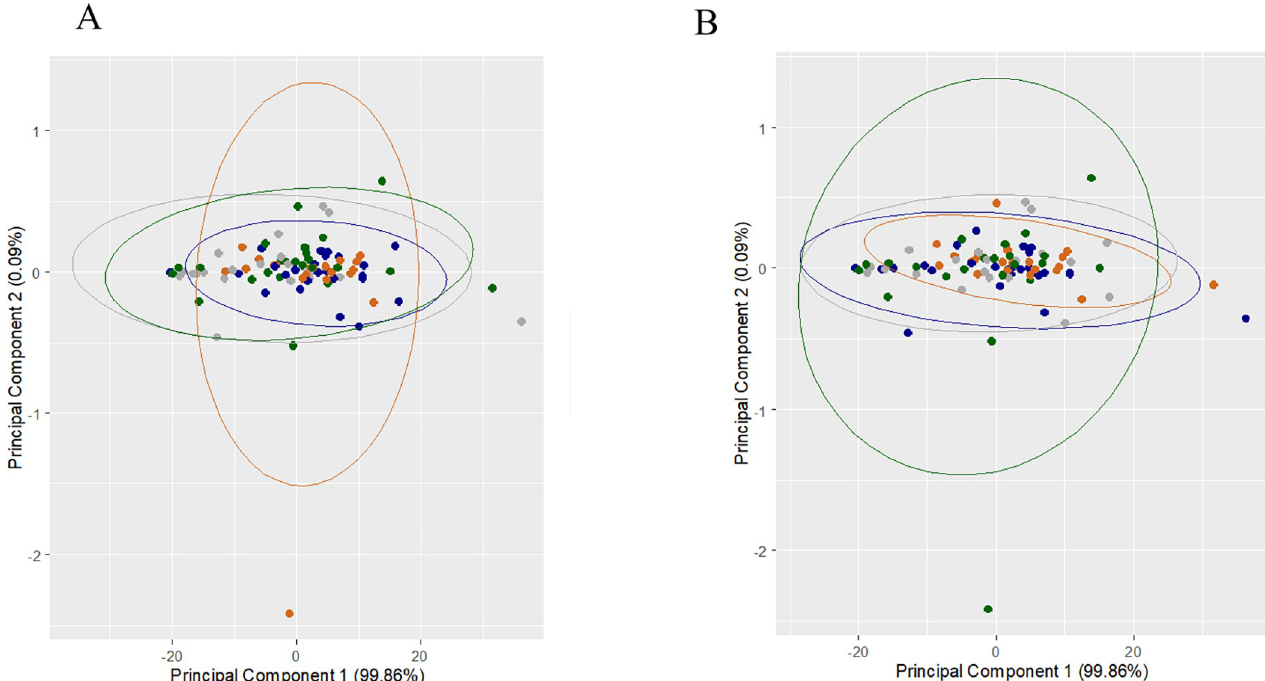
Fig 3. Principal component analysis bi-plot of the relative metabolite intensities of IVF and ICSI derived sibling embryos in relation to paternal factors. A) Bi-plot (PC1 vs PC2) of relative metabolite intensities of IVF and ICSI derived embryos in relation to sperm head defects did not demonstrate differential clustering. Blue dots (•) represents < 15% sperm head defects from IVF and orange dots (•) represents > 15% sperm head defects from IVF; whereas grey dots (•) represents < 15% sperm head defects from ICSI and green dots (•) represents > 15% sperm head defects from ICSI. B) Bi-plot (PC1 vs PC2) of relative metabolite intensity of IVF and ICSI embryos in relation to TUNEL index showed random distribution of data points. Blue dots (•) represents < 10% TUNEL index from IVF and orange dots (•) represents > 10% TUNEL index category from IVF group; grey dots (•) represents < 10% TUNEL index and green dots (•) represents > 10% TUNEL index category from ICSI